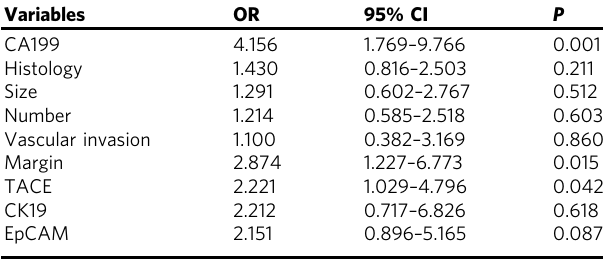
Table 2 Results of multivariate analyses for liver